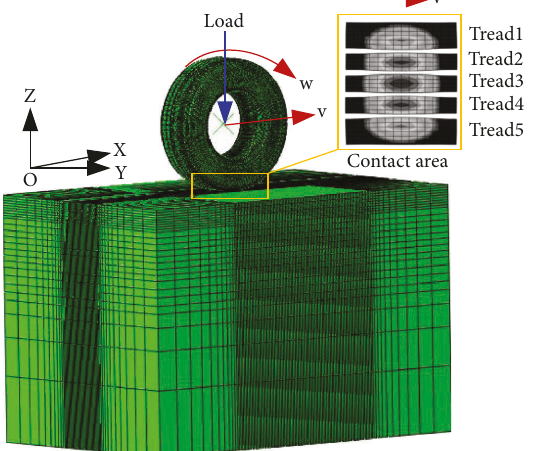
Table 5: Prony series of viscoelastic materials (20 ∘ C ).